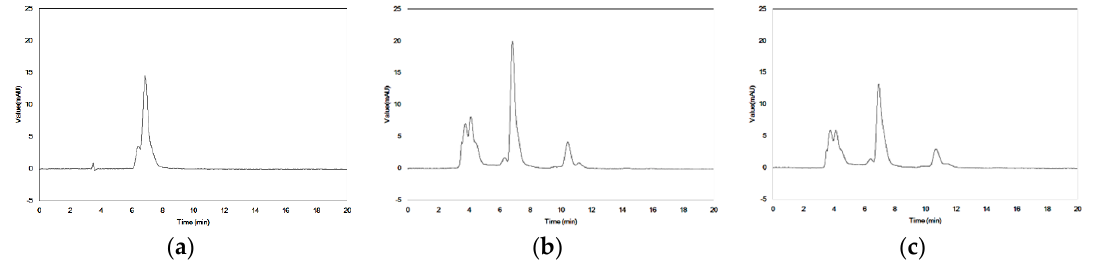
Figure 2. Comparison of High-Pressure Liquid Chromatography (HPLC) analysis of chlorophyll a contents by different extraction conditions. ( a ) Standard (chlorophyll a); ( b ) optimal extraction conditions; ( c ) conventional extraction conditions.